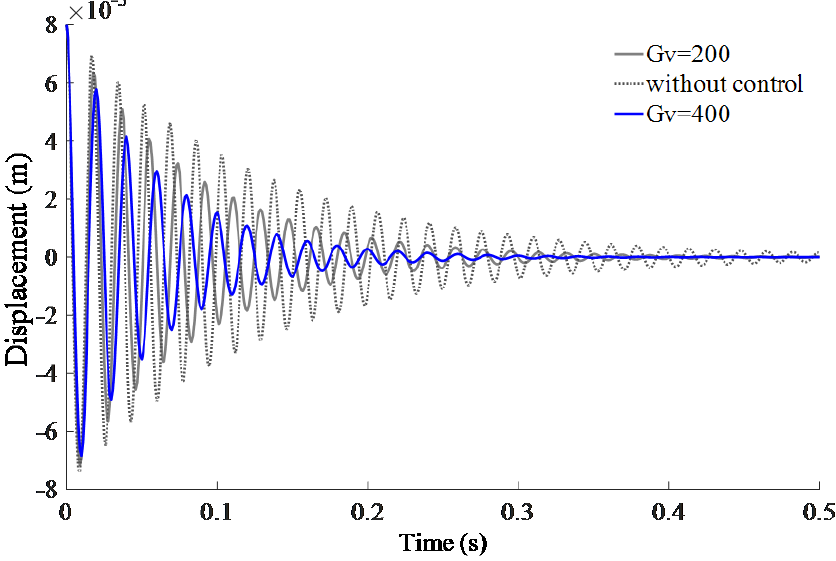
Fig. 7 Tip deflection of clamped-clamped beam with and without